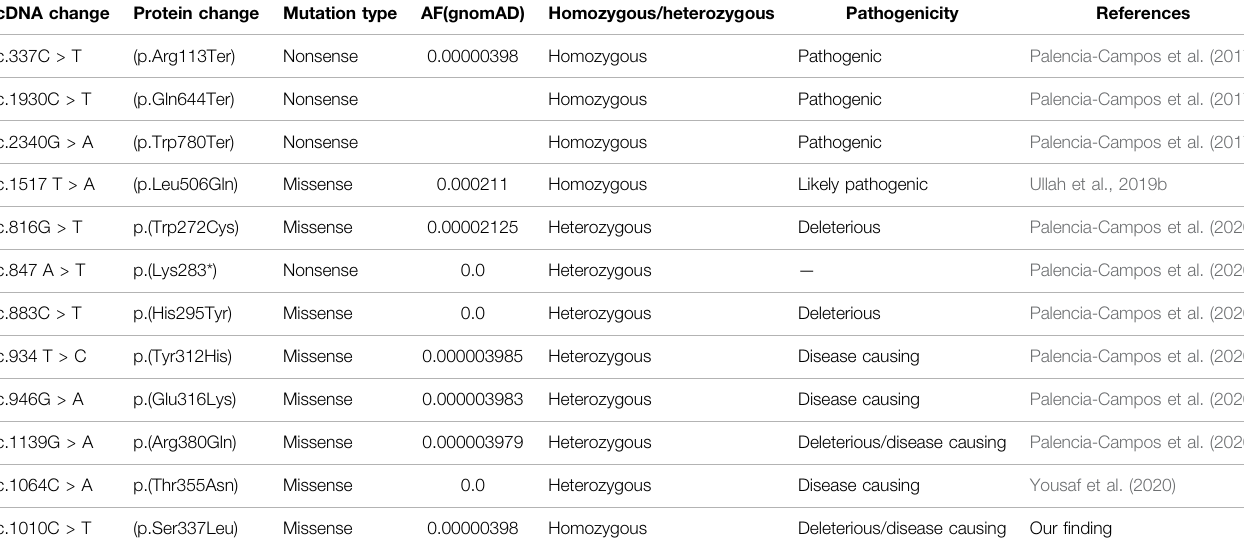
TABLE 4 | List of mutations/variants already reported until now in GLI1 gene for PAPA. cDNA change Protein change Mutation type AF(gnomAD)